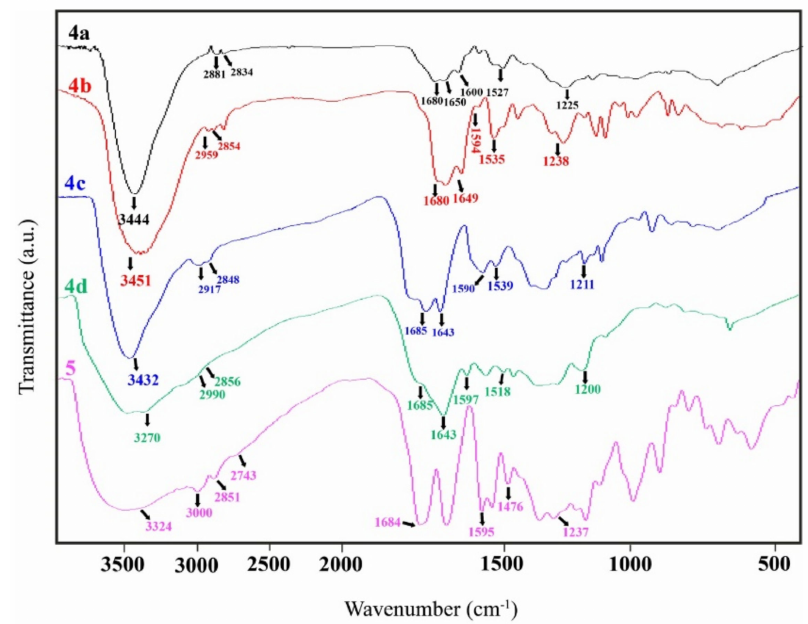
Figure 1. FTIR of 4a, 4b, 4c, 4d and 5 phenolic